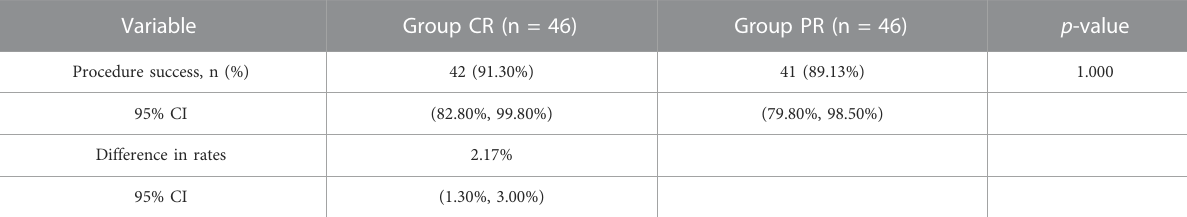
TABLE 2 The primary outcome in this